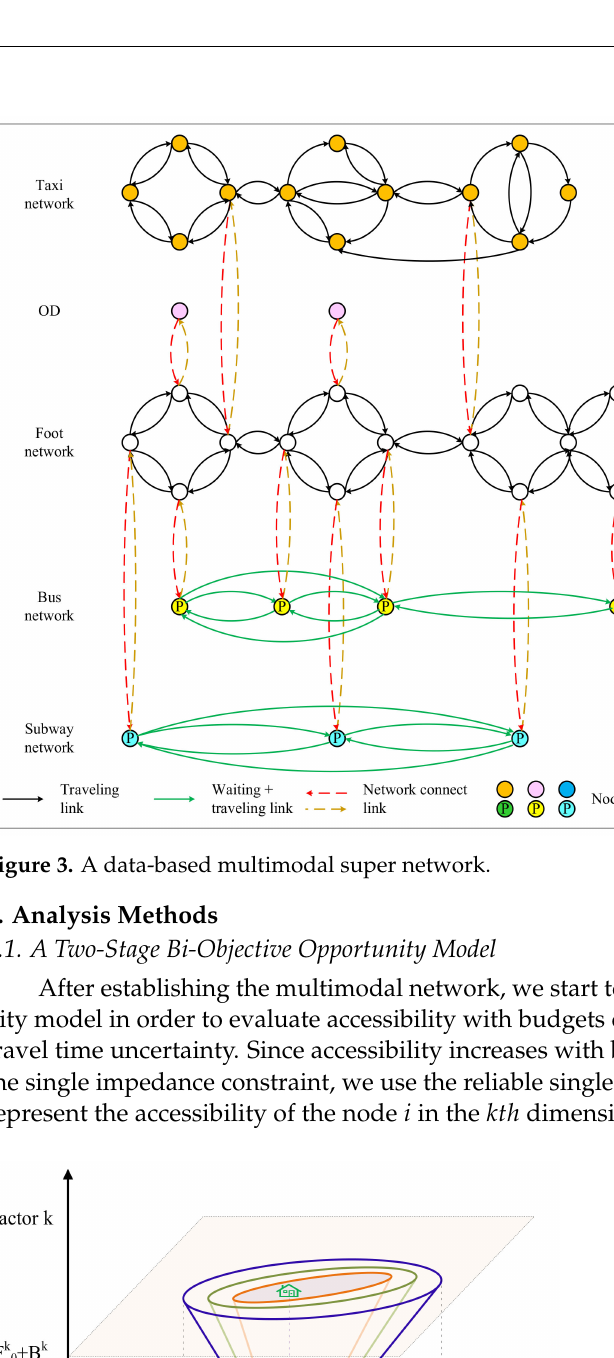
is the initial value and B k is the 0